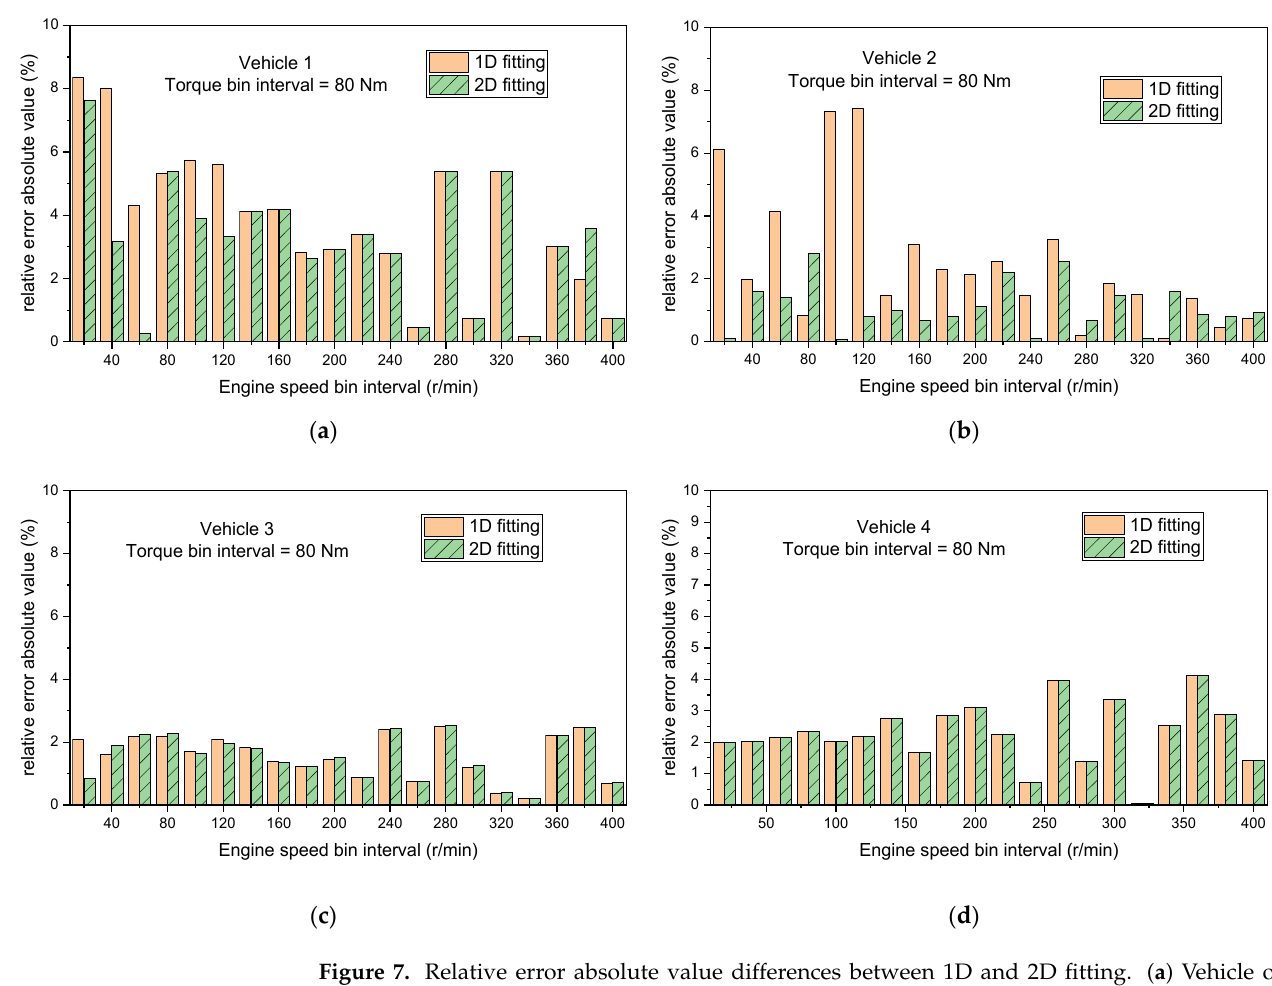
Figure 7. Relative error absolute value differences between 1D and 2D fitting. ( a ) Vehicle one. ( b ) Vehicle two. ( c ) Vehicle three. ( d ) Vehicle four.